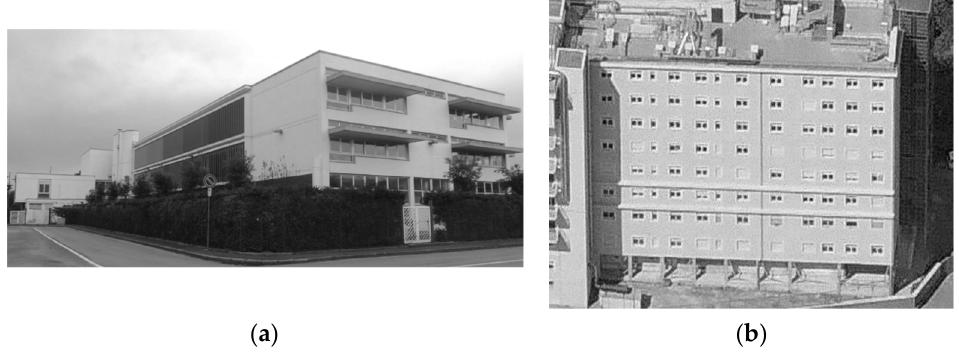
Figure 12. View of the two Case Studies ( a ) CS1 and ( b ) CS2